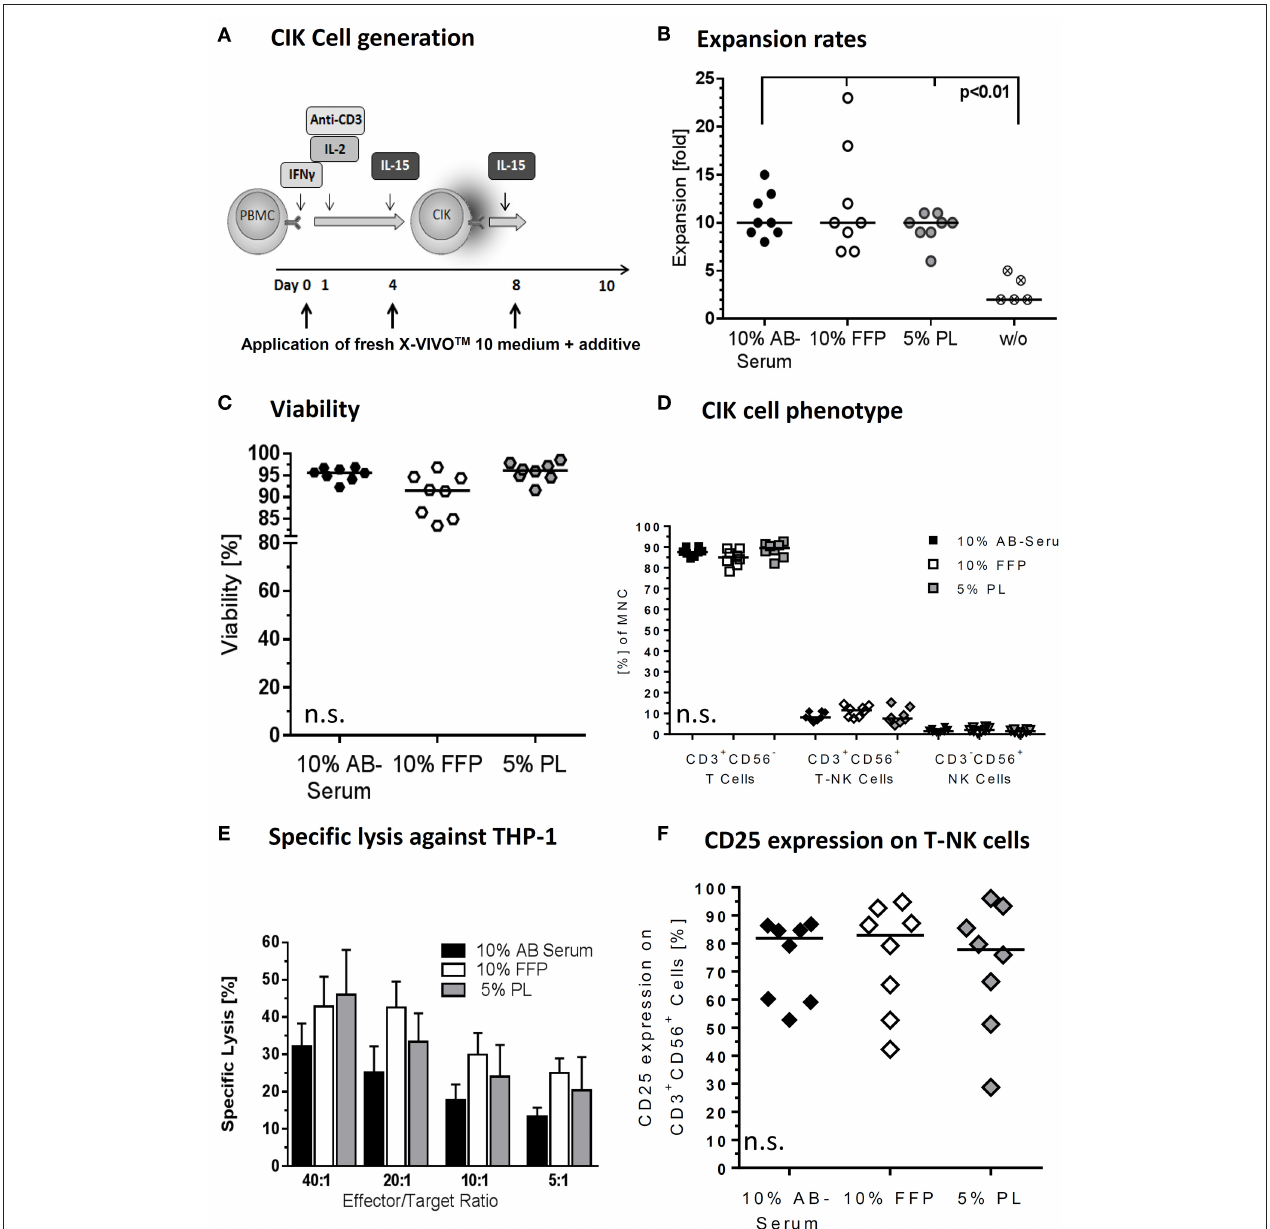
FIGURE 2 | Medium supplements for CIK cell cultivation. (A) CIK cells are supplemented with fresh media including different additives on days 0, 4, and 8 of culture. We tested different additives including fresh frozen plasma (FFP) and platelet lysate (PL) in different concentrations to substitute AB serum in the cultivation process. (B) With median 10-fold expansion rates, CIK cell cultivation with 10% AB serum, 10% FFP and 5% PL was similar. CIK cell expansion without additive was significantly lower compared to cultivation with medium supplement. (C) With 91.5% viability was minimal lower when CIK cells were cultured with FFP compared to AB serum (95.6%) or PL (96.1%), but not statistically relevant. (D) The composition of CIK cells consisting of T-, T-NK-, and NK-cells was not significantly influenced by the different cultivation variants. (E) CIK cell cytotoxicity was tested against the leukemic cell line THP-1. In the effector/target ratio of 40:1 mean specific lysis was with 46.0% highest for PL-CIK cells, closely followed by FFP-CIK cells with 42.9%. In the effector/target ratios 20:1, 10:1, and 5:1, CIK cells generated with FFP as additive showed the highest cytotoxicity. (F) CD25 expression on T-NK cells was highest on CIK cells cultivated with FFP. Comparable results were obtained for CIK cells cultured with AB serum. CIK cells cultivated with PL as medium additive showed a slightly lower CD25 expression and a wider range of expression. n = 8 experiments, except cultivation without medium supplement ( n = 5) and cytotoxicity analysis ( n =